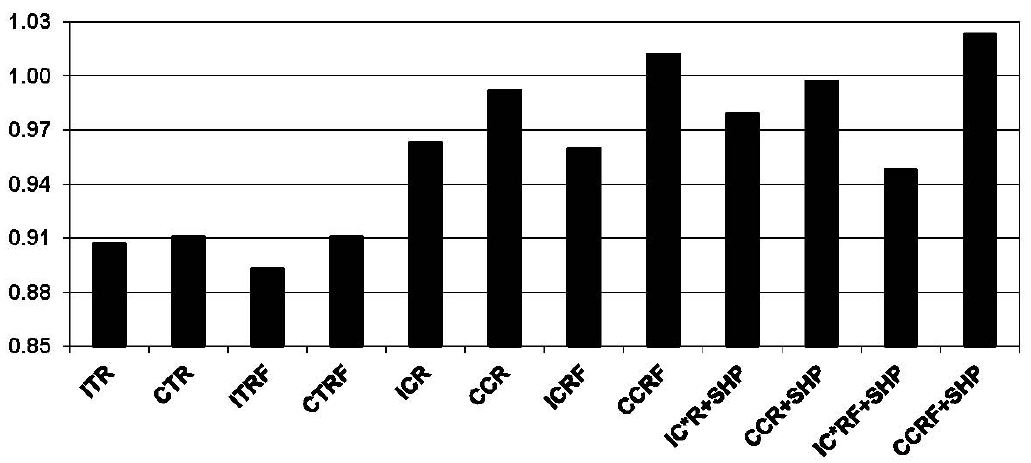
Figure 6. Boiler and auxiliaries efficiency of heating systems.